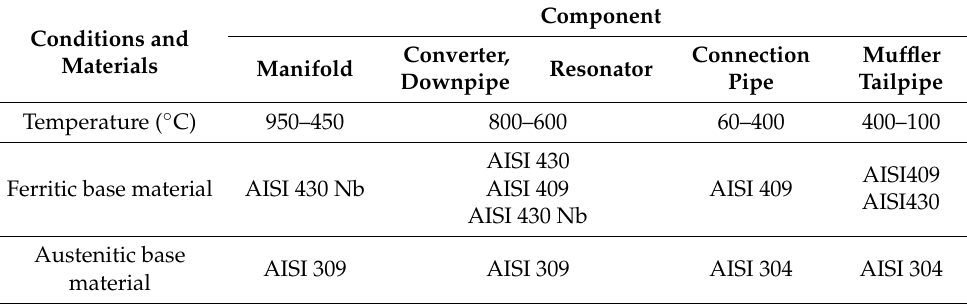
Table 1. Stainless steels used for exhaust system parts